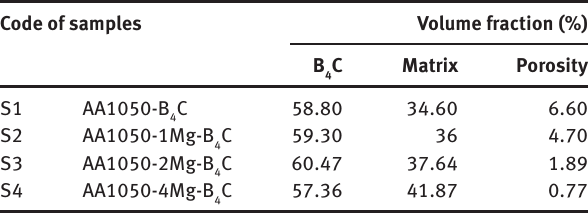
Table 1: Image analysis results of the investigated compacts. Code of samples Volume fraction